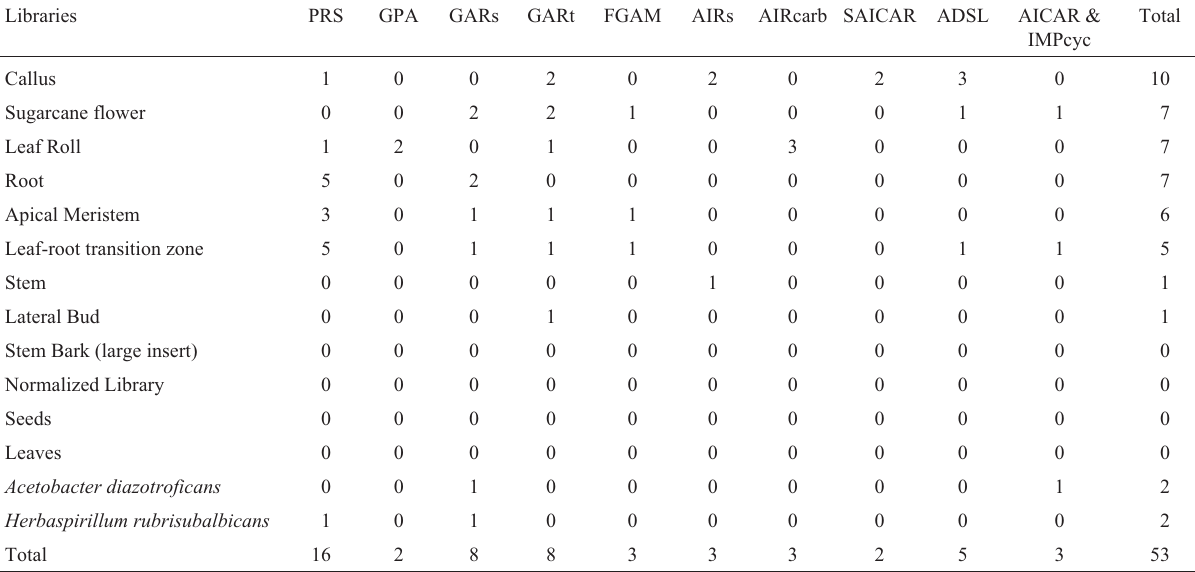
Table I - Frequency of purine synthesis homologue EST clones per